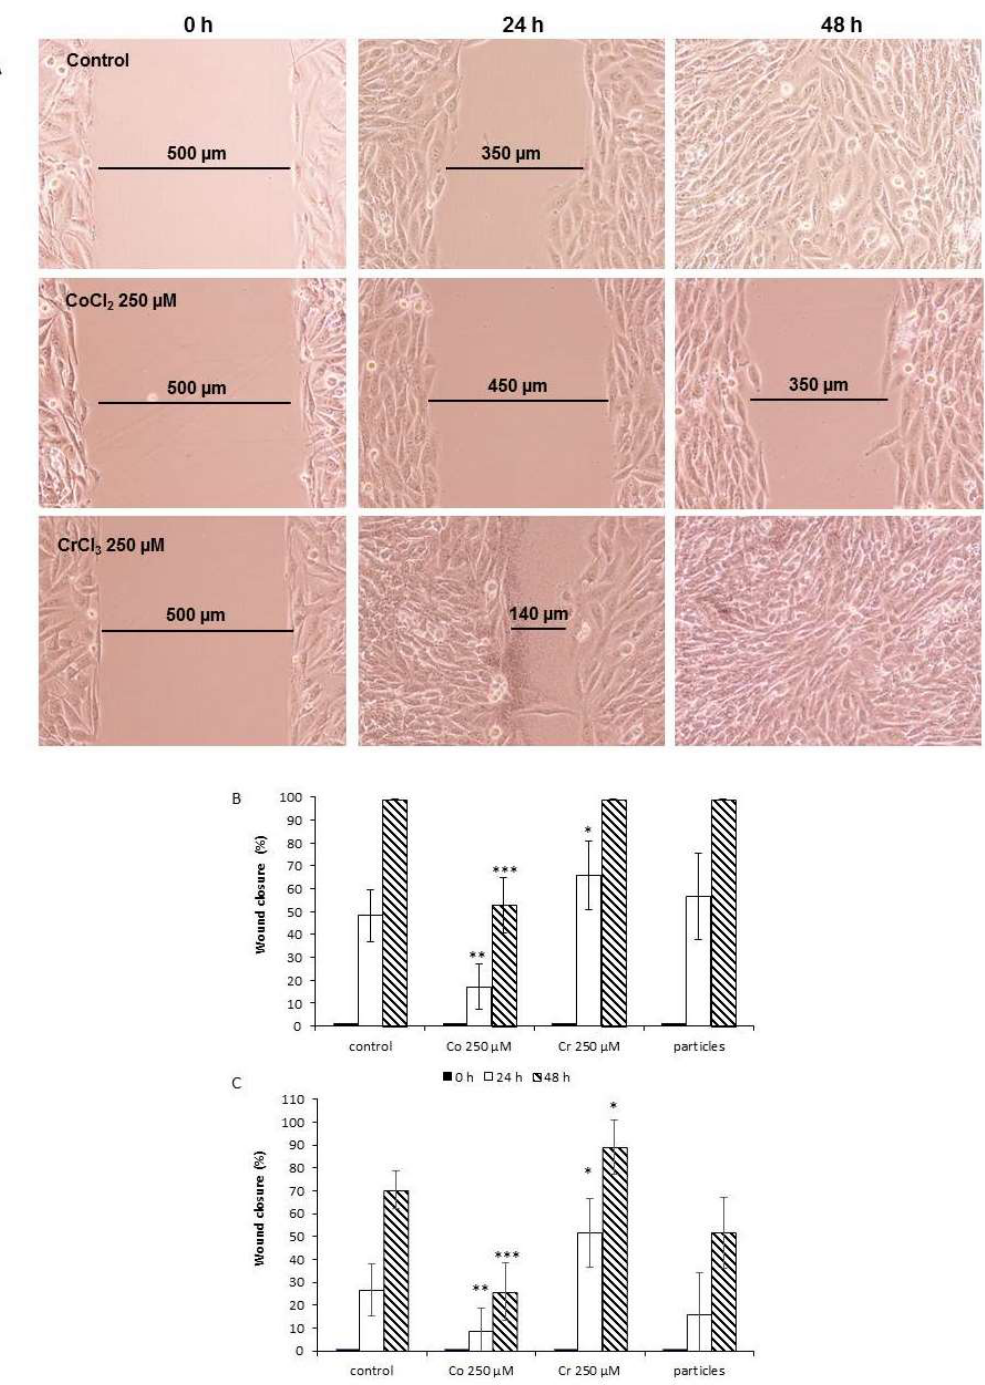
Figure 2. Effect of treatment with CoCl 2 , CrCl 3 , and CoCr particles on relative wound closure in MG63 and SaOs2 cells, measured using ibidi ® silicone inserts in an in vitro wound healing assay over 48 h. ( A ) Representative images of MG63 cells. Summary of the wound healing assay results for ( B ) MG63 and ( C ) SaOs-2 cells. Data represent the mean of four independent experiments. Data were examined in the time course using ANOVA (MG63: Co 2+ p < 0.0001, Cr 3+ p < 0.05, CoCr particles not significant; SaOs-2: Co 2+ p < 0.001, Cr 3+ p < 0.01, CoCr particles p < 0.01). For comparison of paired samples of treated cells vs. untreated control the post-hoc Bonferroni test was used (* p < 0.05, ** p < 0.01, *** p < 0.001).